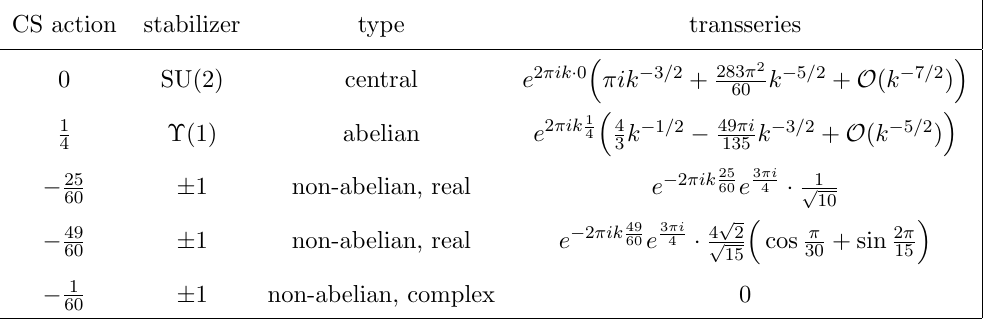
1; 1 ; 1 ; 1 ), after modding out 2 3 10 (cid:0)